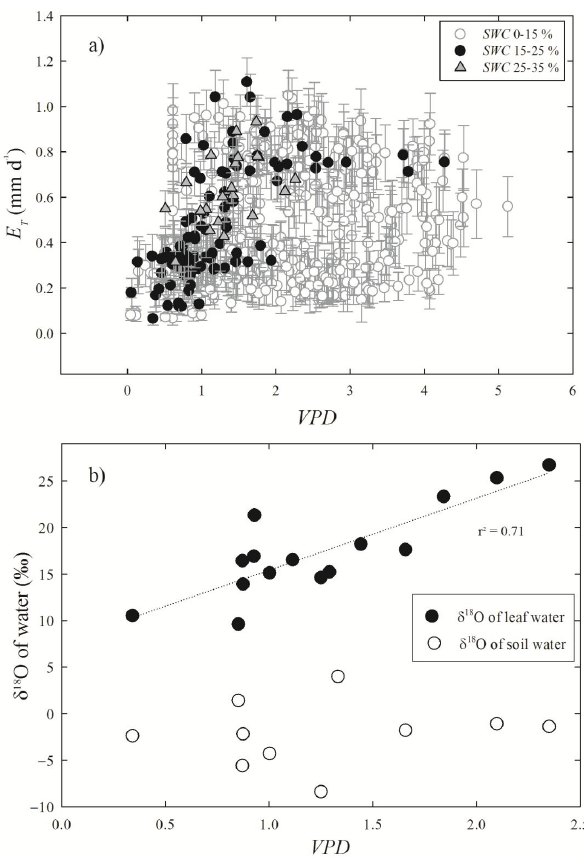
Fig. 3. (a) The interannual and seasonal E T –VPD relationships for three sets of SWC, 0–15%, 15–25%, and 25–35%. (b) Correlations of foliar and soil water δ 18 O values at 10cm depth with VPD for year 2005 and 2006. The foliar regression equation is δ 18 O = 7.7 + 7.7 VPD, r 2 = 0 . 7. Soil water δ 18 O value was not significantly correlated with VPD.